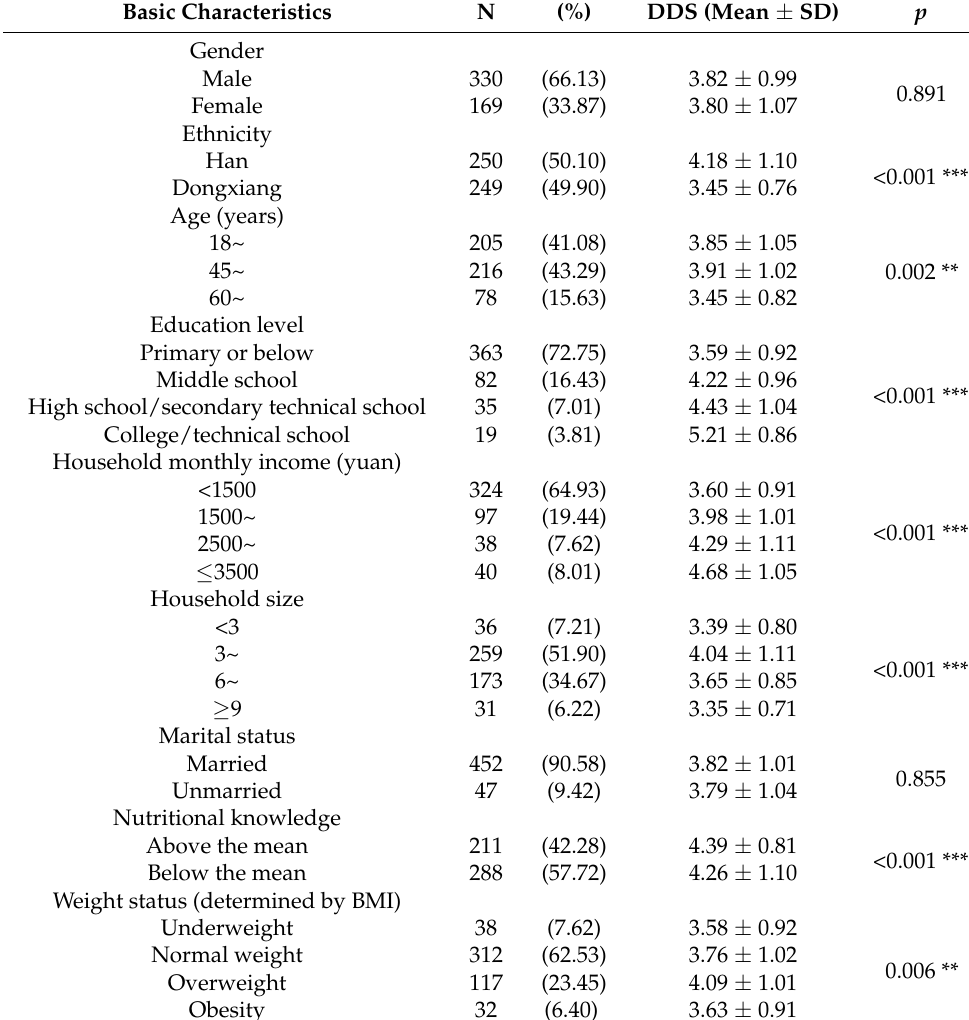
Table 1. Dietary diversity scores and basic characteristics of participants ( N =